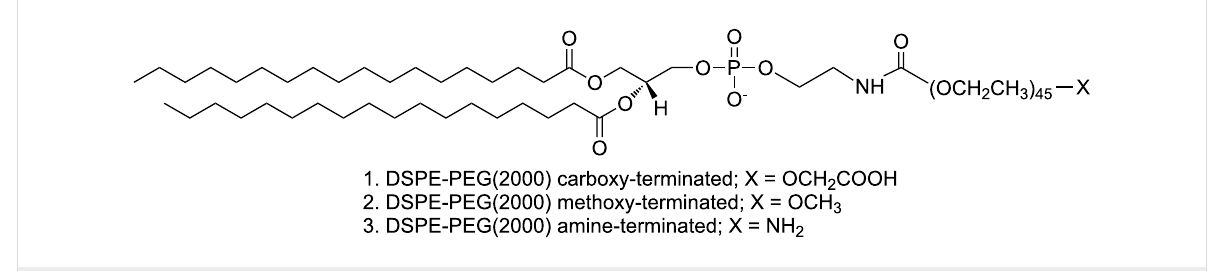
Figure 3: Molecular structure of DSPE–PEG (2000) carboxy-terminated, methoxy-terminated and amino-terminated formulations.